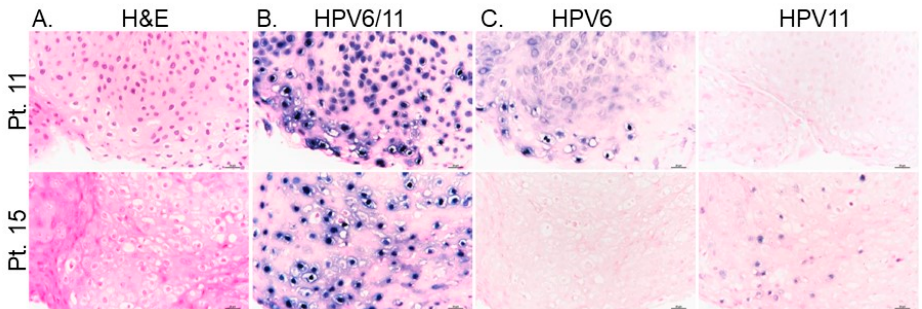
Figure 6. A two-step approach to optimize detection of HPV infection with HPV6/HPV11 subclassification. ( A ) Representative H&Es of papillomas from patient 11 and patient 15 that were previously HPV genotyped as HPV6+ and HPV11+, respectively. ( B ) Clinically validated low-risk combined HPV6/11 DNA-ISH showing robust staining in many cells. ( C ) RNA-ISH using strain-selective HPV6 and HPV11 probes showing restricted HPV6 or HPV11 staining in patients 11 and 15, respectively. Note the reduced number of positive cells using the HPV6 and HPV11 RNA selective probes as compared to the combined HPV6/11 DNA probes on serial sections from the same papillomas. Scale bar, 25 μ m.